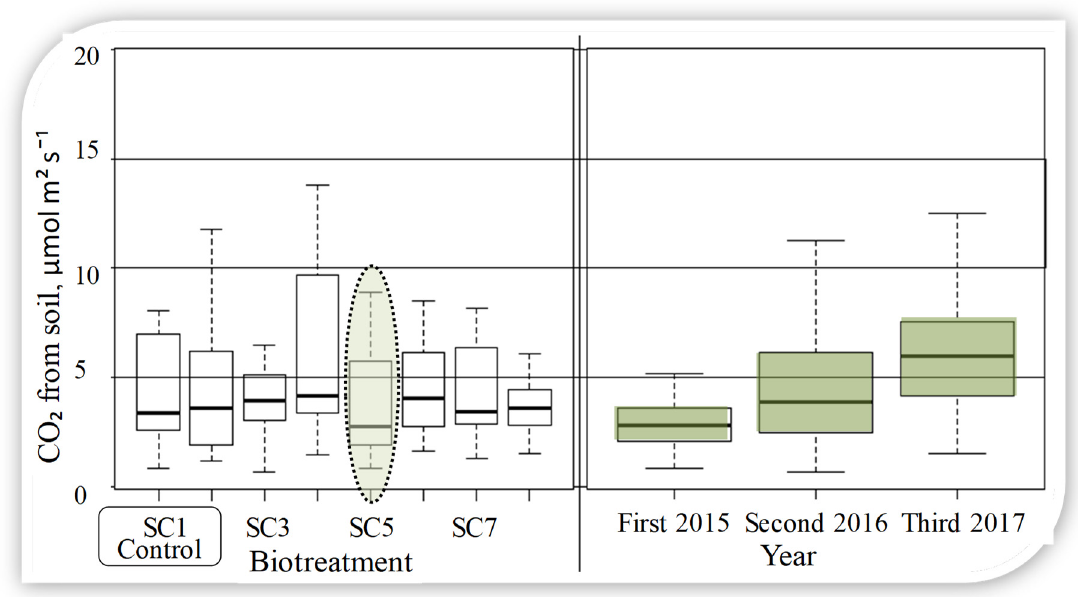
Figure 5. CO 2 from soil (µmol m 2 s –1 ) dependence on bio-impact(s) time (year) and scenario.